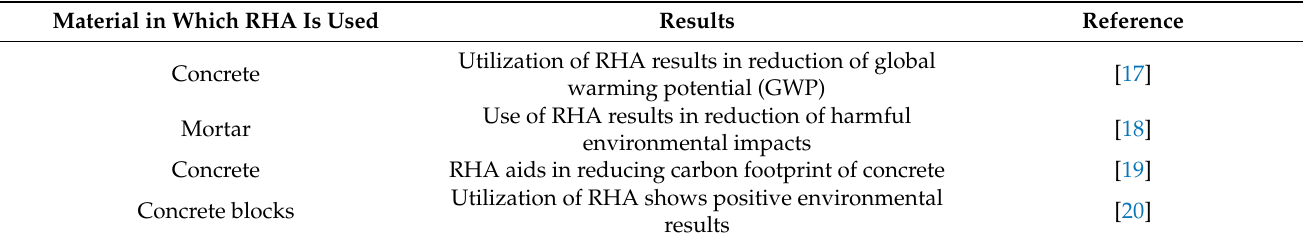
Table 1. Environmental impact of rice husk ash